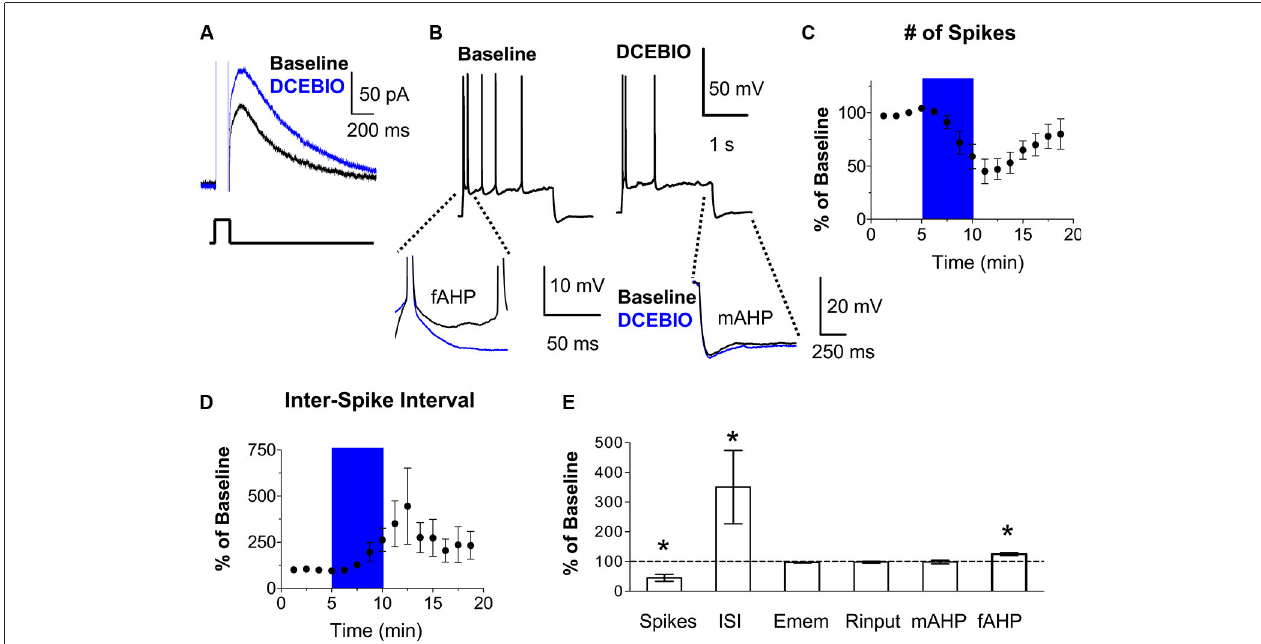
second spike, and the mAHPs from the same traces. (C–D) Time courses showing that application of DCEBIO (blue area) decreased the number of evoked spikes and increased the first ISI, consistent with reduced bursting in IL. (E) Summary of the effects of DCEBIO on spike count, ISI, Emem, Rinput, mAHP, and fAHP. n = 5; * p < 0.05.